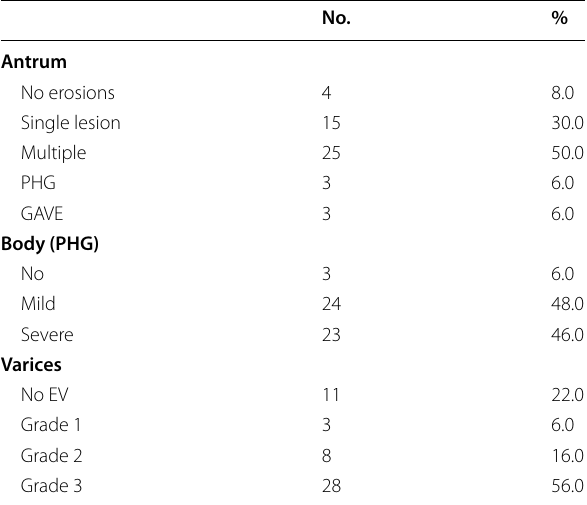
Table 2 Distribution of findings in the studied cases